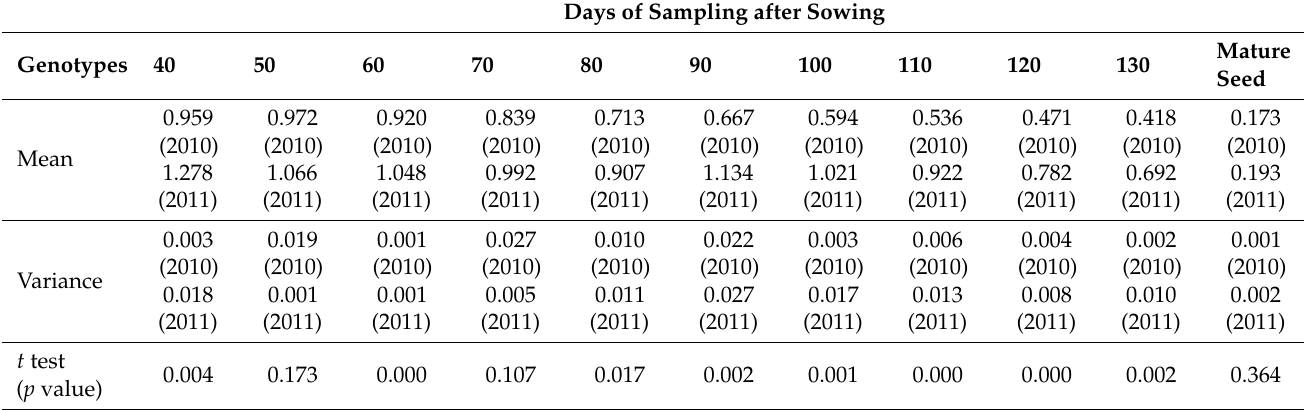
Table 9. Mean total ODAP content (%) in different plant development stages in L. sativus during